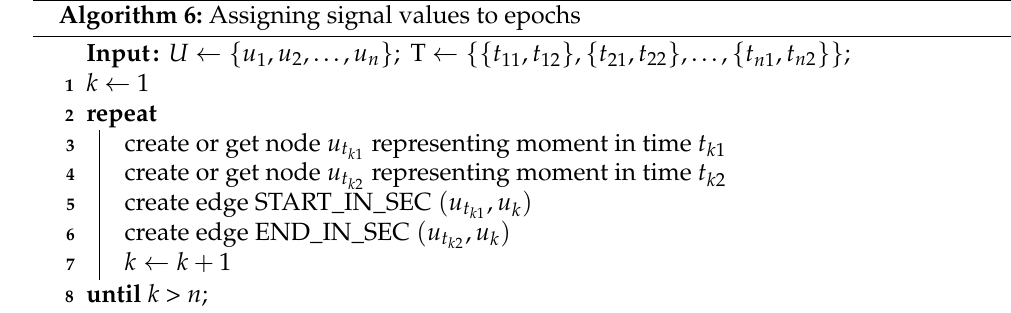
Algorithm 6: Assigning signal values to epochs